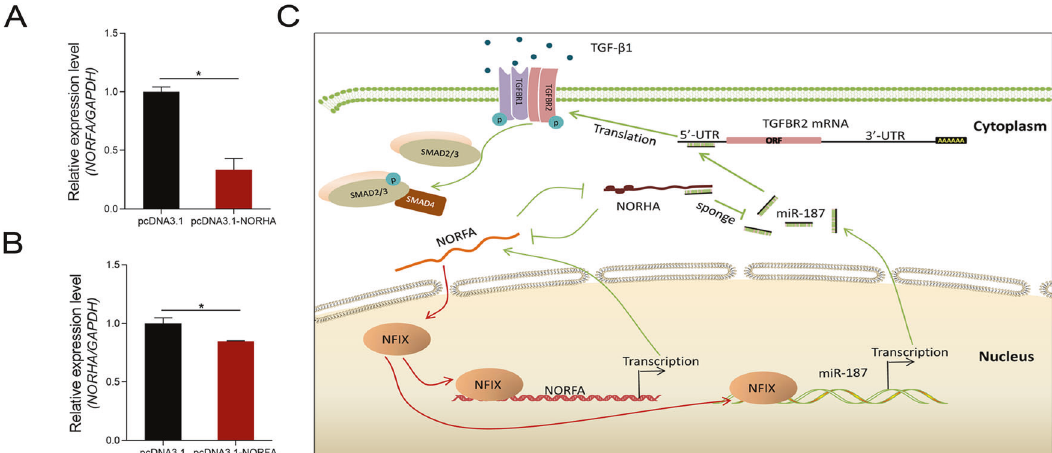
Fig. 7 A small regulatory network of functional genes for GC apoptosis and follicular atresia. A NORFA levels were measured using qPCR in NORHA-overexpressing GCs. B NORHA levels were measured using qPCR in NORFA-overexpressing GCs. C This network comprises three ncRNAs (miR-187, NORHA, and NORFA), two feedback loops (NORFA-NFIX and NORHA-NORFA), and one signaling pathway (TGF- β ). Four hub genes (NORHA, NORFA, miR-187, and TGFBR2) in this network are strongly associated with follicular atresia by in fl uencing GC apoptosis. Red dotted arrows have been demonstrated by our previous studies [22, 24]. Data represent means ± SEM for three independent experiments. * p <